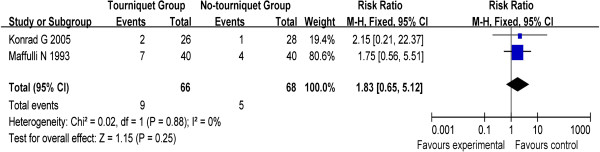
Meta-analysis of postoperative infection rate in the tourniquet and non-tourniquet groups.